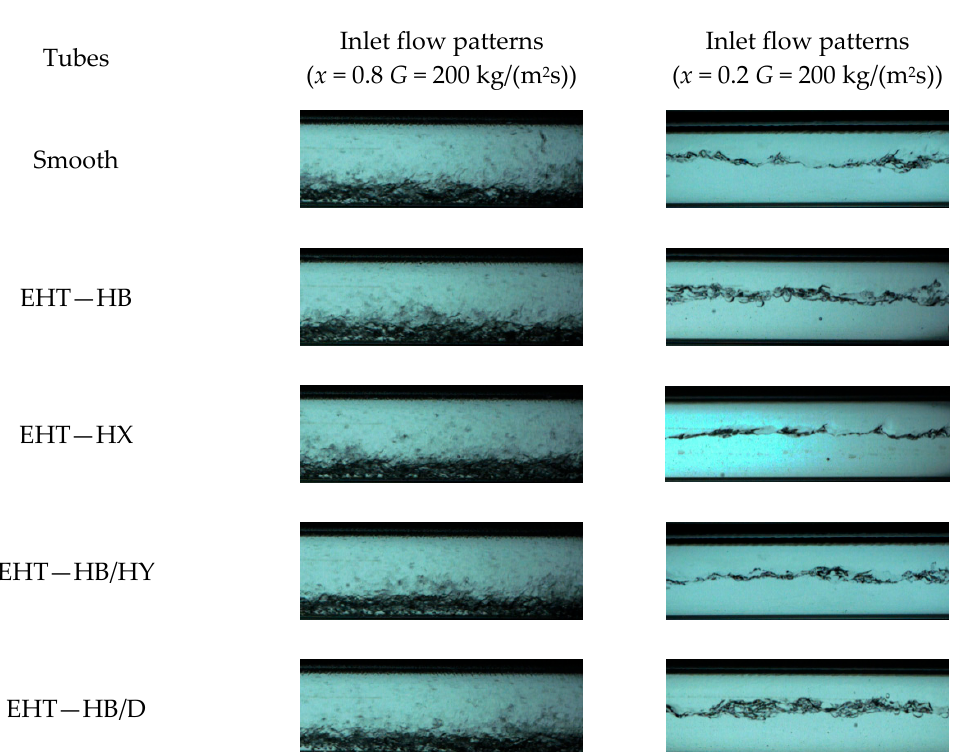
Figure 6. Condensation flow patterns for the tested tubes at the inlet and outlet ( G = 200 kg/(m 2 s).